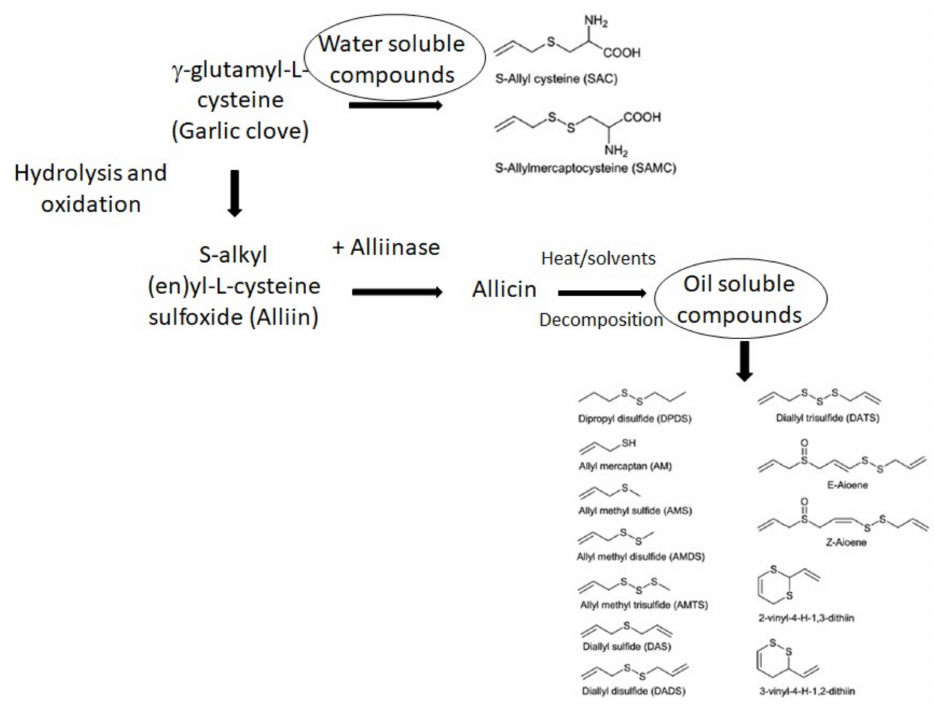
Figure 2. OSCs from garlic. Intact clove garlic contains γ -Glutamyl-S-alk(en)yl-L-cysteines, the primary sulfur compounds, which with hydrolysis or oxidation can be converted into alkyl (en)yl- L-cysteine sulfoxide, commonly called Alliin. When garlic is crushed or cut, the vacuolar enzyme alliinase converts alliin to allicin, poorly soluble in water and responsible for the characteristic pungent flavor of garlic. Allicin is very unstable and rapidly decomposed to form a variety of oil-soluble compounds, including diallyl disulfide (DADS), diallyl sulfide (DAS), diallyl trisulfide (DATS), vinyl dithiin and ajoene, according to different conditions. When garlic is extracted in an aqueous solvent, γ -glutamyl -S-alk(en)yl-L-cysteines can be converted into water-soluble compounds, mainly S -allyl-cysteines (SAC) and S-allylmercaptocysteine (SAMC), which are less odorous than the oil-soluble products but are stable and have important antioxidants and bioactive